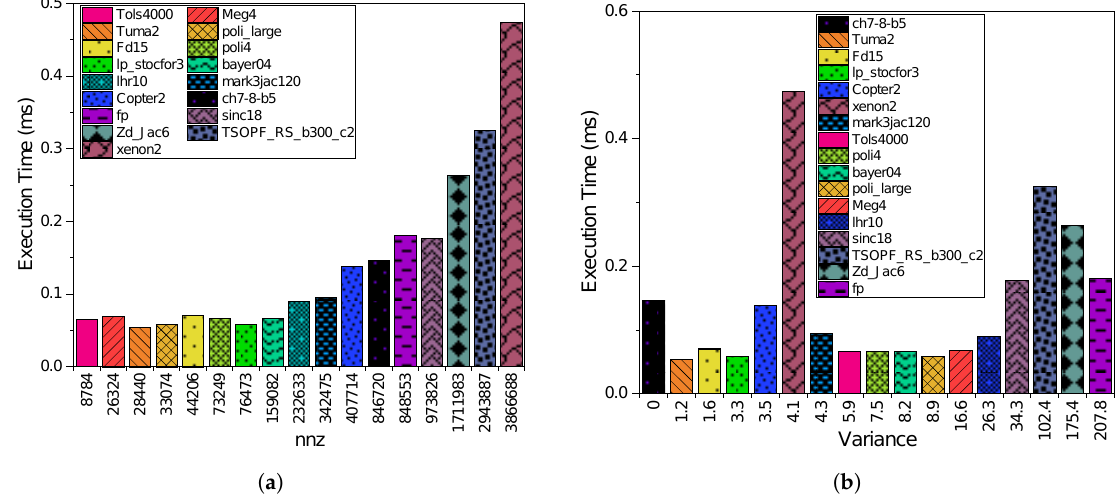
Figure 16. Compressed sparse row 5 (CSR5) execution time against: ( a ) nnz and ( b ) npr variance . Figure 16b plots a comparison between execution time and variance for the CSR5